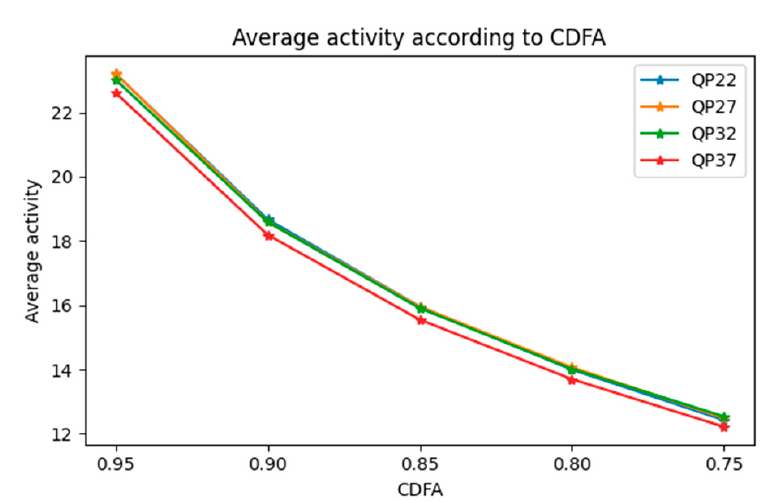
Figure 9. The average activity changes according to CDFA.